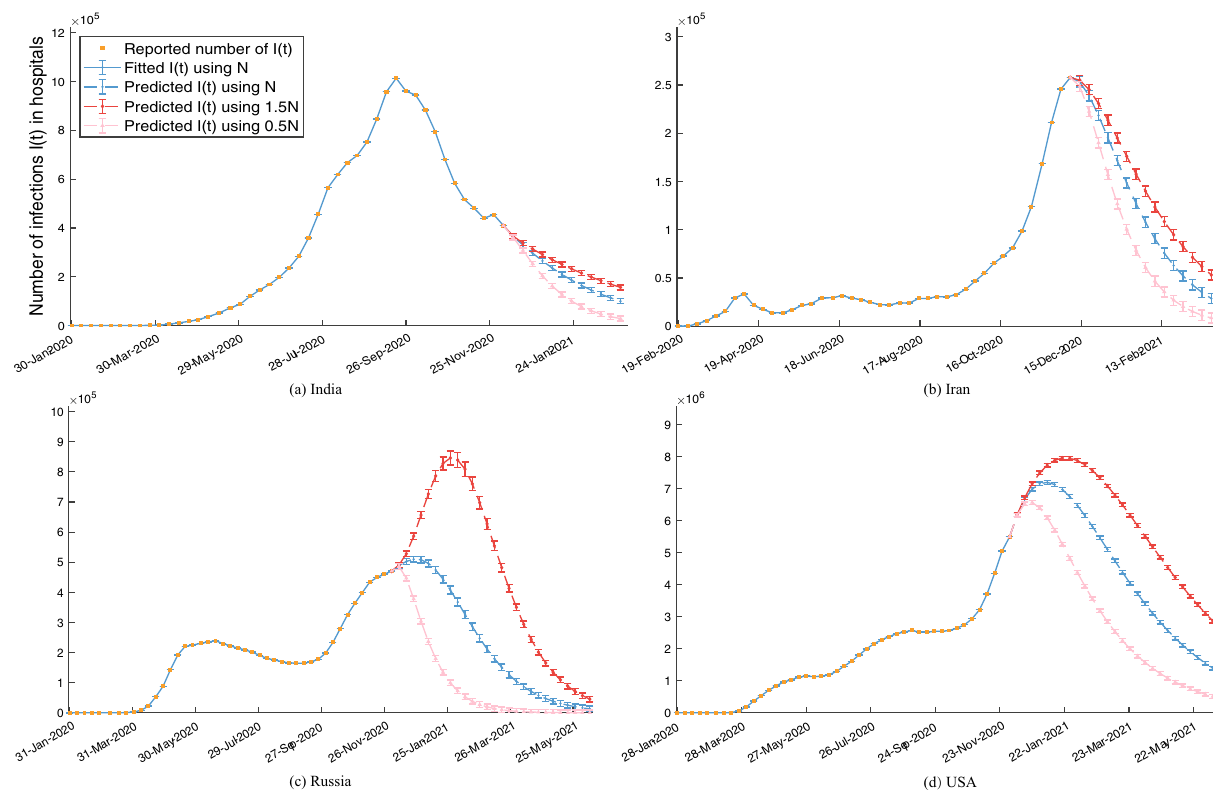
Figure 6. The impact of different control intensities implemented by changing the population size on the I ( t